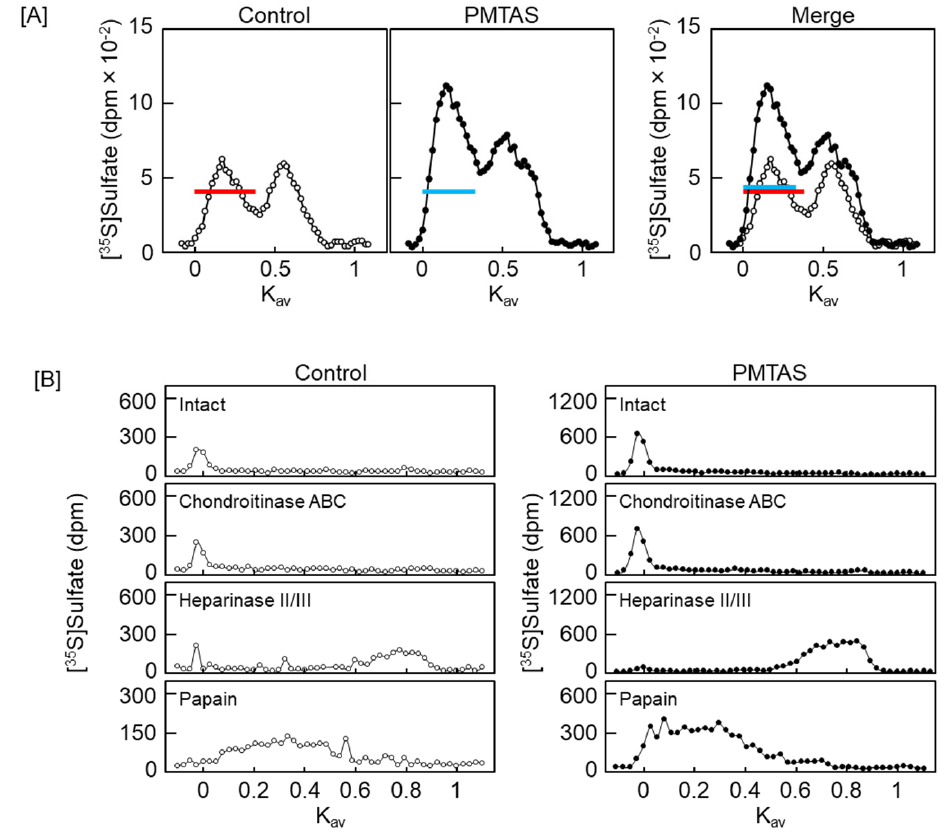
Figure 6. Characterization of proteoglycans based on hydrodynamic size: ( A ) High charged molecules pooled after DEAE-Sephacel anion-exchange chromatography were separated by Sepharose CL-4B molecular sieve chromatography. The fractions within the range of red and blue horizontal bars are pooled as high molecular weight subclass; ( B ) proteoglycans included in the high molecular weight subclass were digested with chondroitinase ABC, heparinase II/III, or papain, followed by separation via Sepharose CL-6B molecular sieve chromatography.